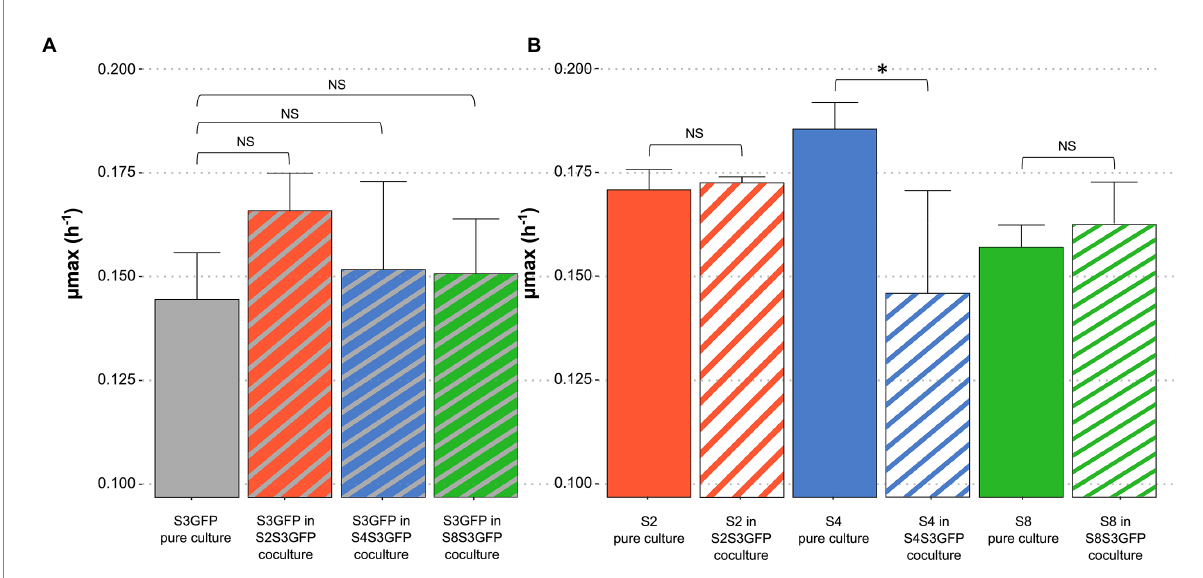
FIGURE 2 Comparison of maximum growth rate of each strain in pure and coculture. Maximum growth rate of each S. cerevisiae strain population ( μ max), in Chardonnay, as a function of (A) S3GFP in pure culture or in each coculture for each modality: S2S3 (Orange), S4S3 (Blue) and S8S3 (Green) and (B) S2, S4 and S8 in pure culture and in each coculture for each modality: S2S3 (Orange), S4S3 (Blue) and S8S3 (Green). μ max was expressed in h − 1 . Values correspond to the average of three biological replicates and error bars represent the standard deviation. Statistical analysis was performed between both pure culture and coculture for each strain involved ( t -test, value of p < 0.05) (NS: non-significant), *significant